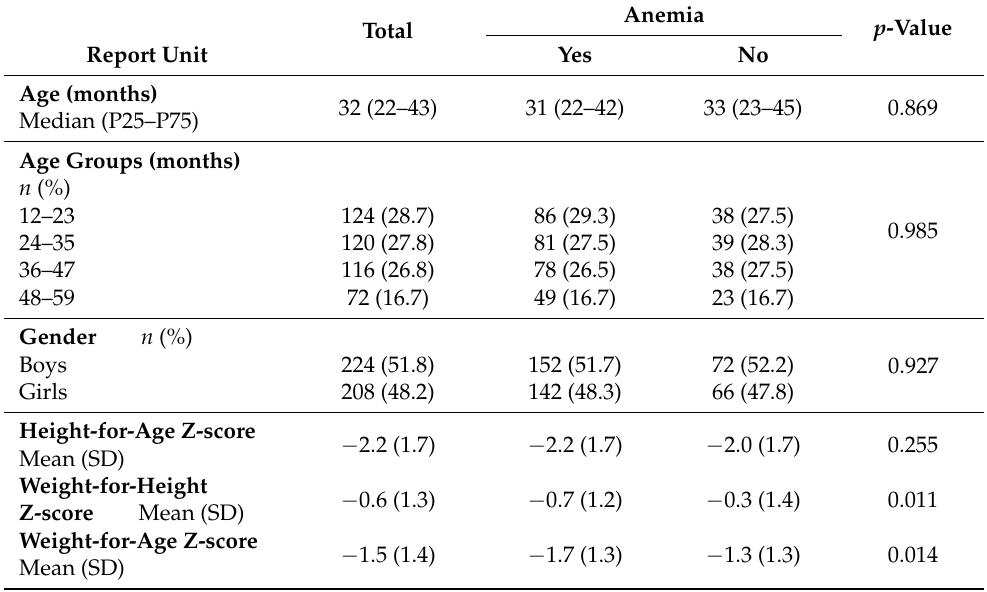
Table A1. General characteristics and anthropometry of children aged 1–5 years in